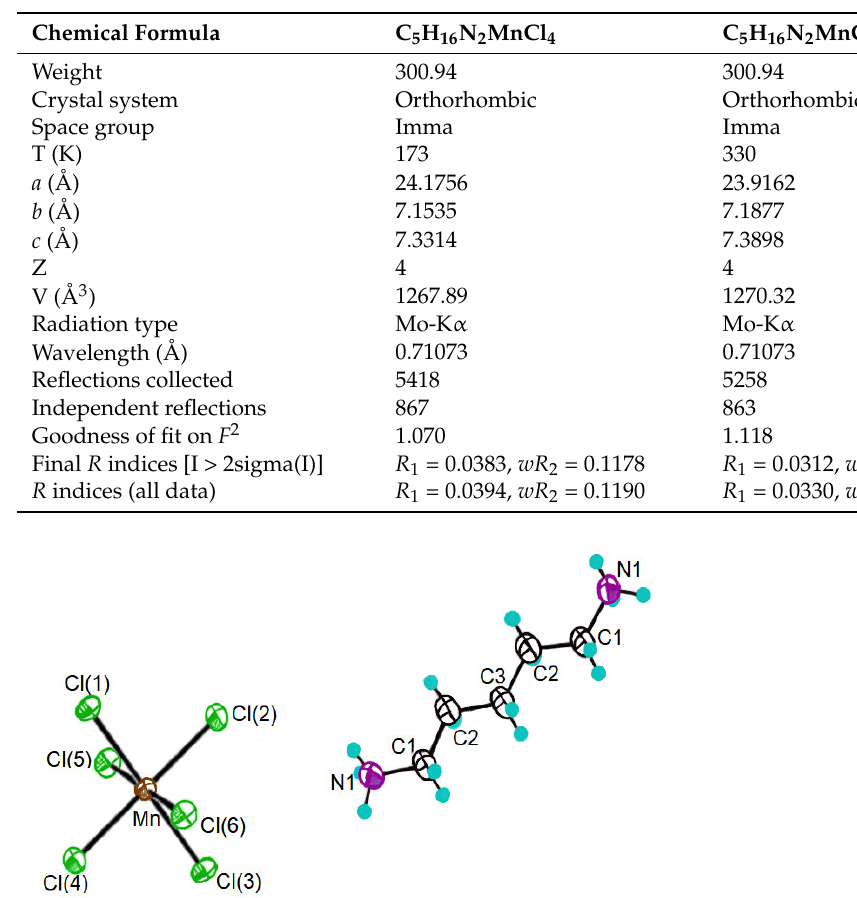
Table 1. Crystal data and structure refinement for [NH 3 (CH 2 ) 5 NH 3 ]MnCl 4 at 173 K and 330 K. The full data are available in the CIF files.